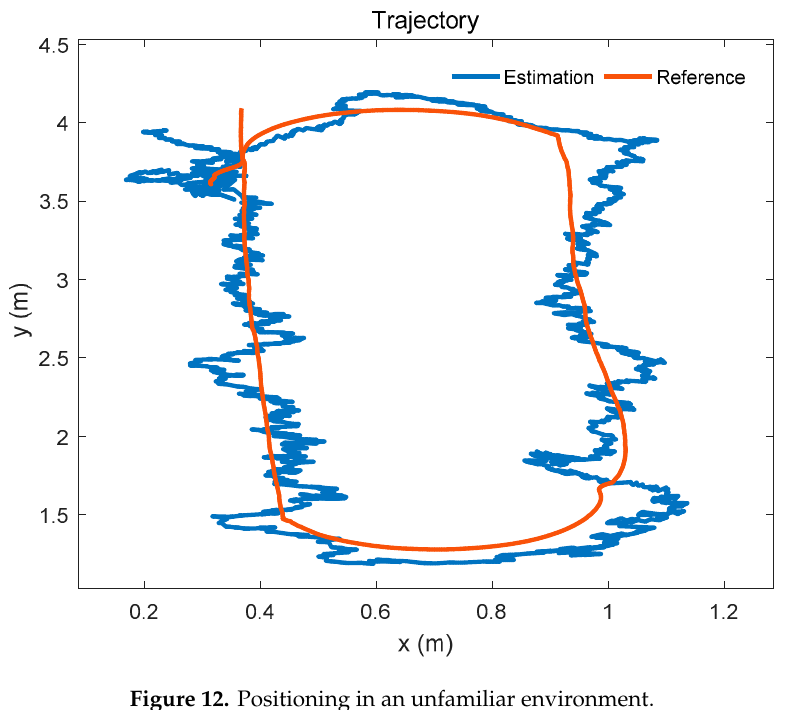
Figure 12. Positioning in an unfamiliar environment.